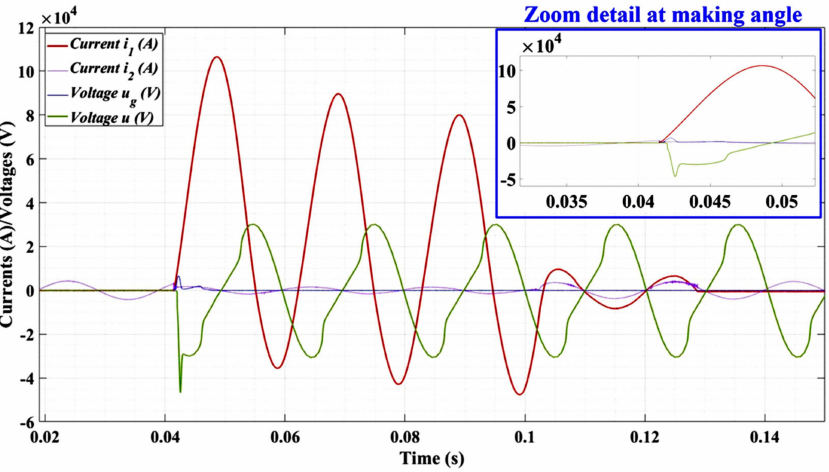
Figure 18. Simulated oscillogram obtained for I 1 with detail on making angle.